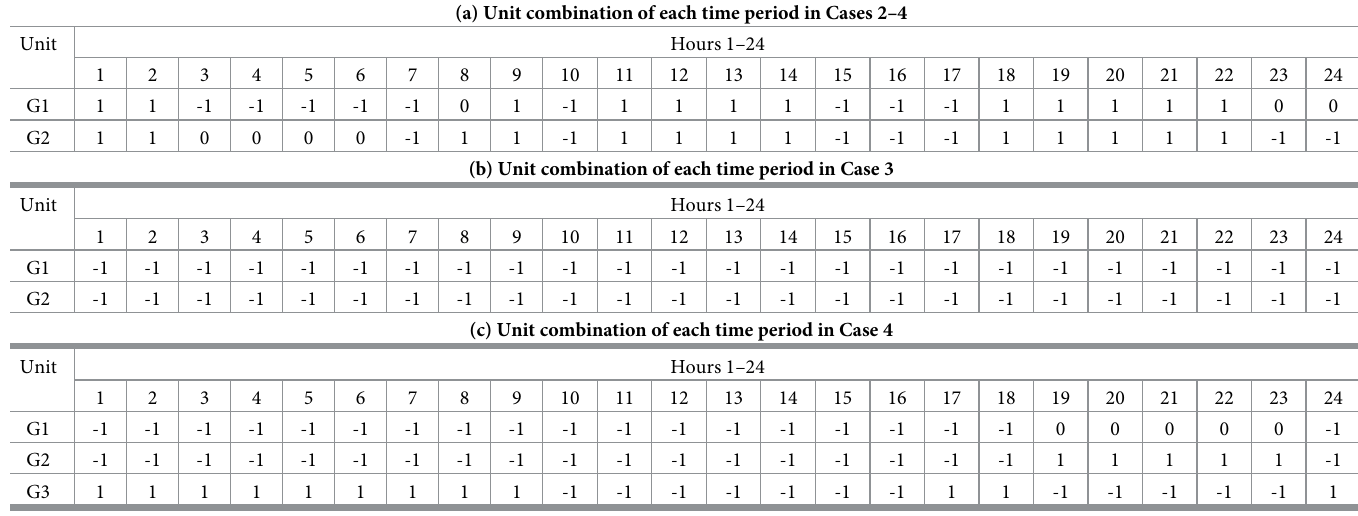
Table 1. Unit combination of each time period in Cases